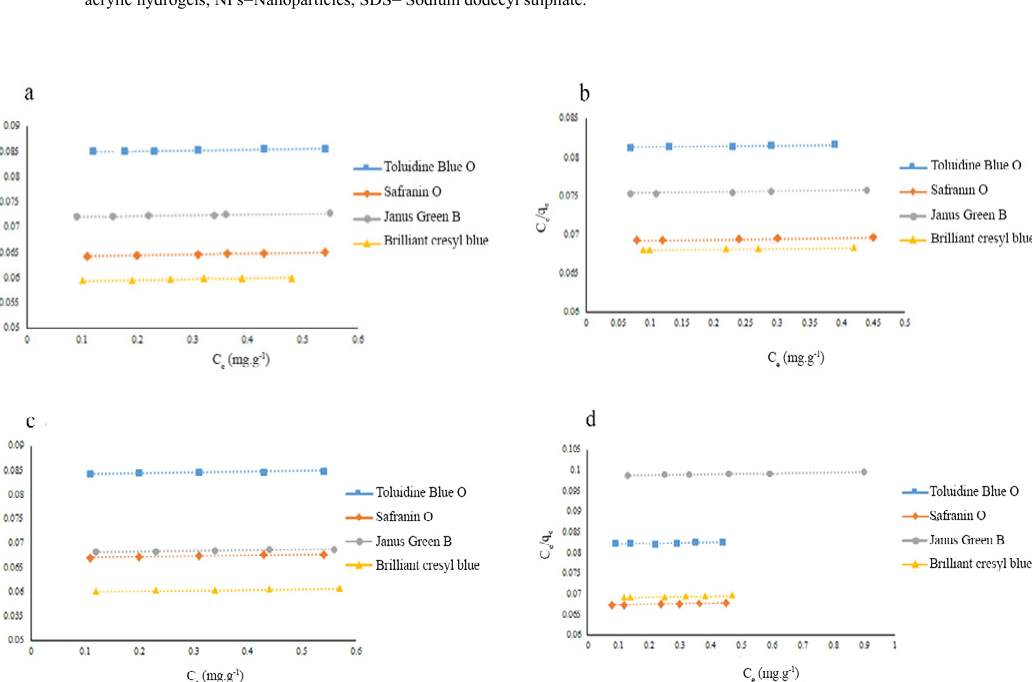
((a), (b) at 308 and 318 K, 2